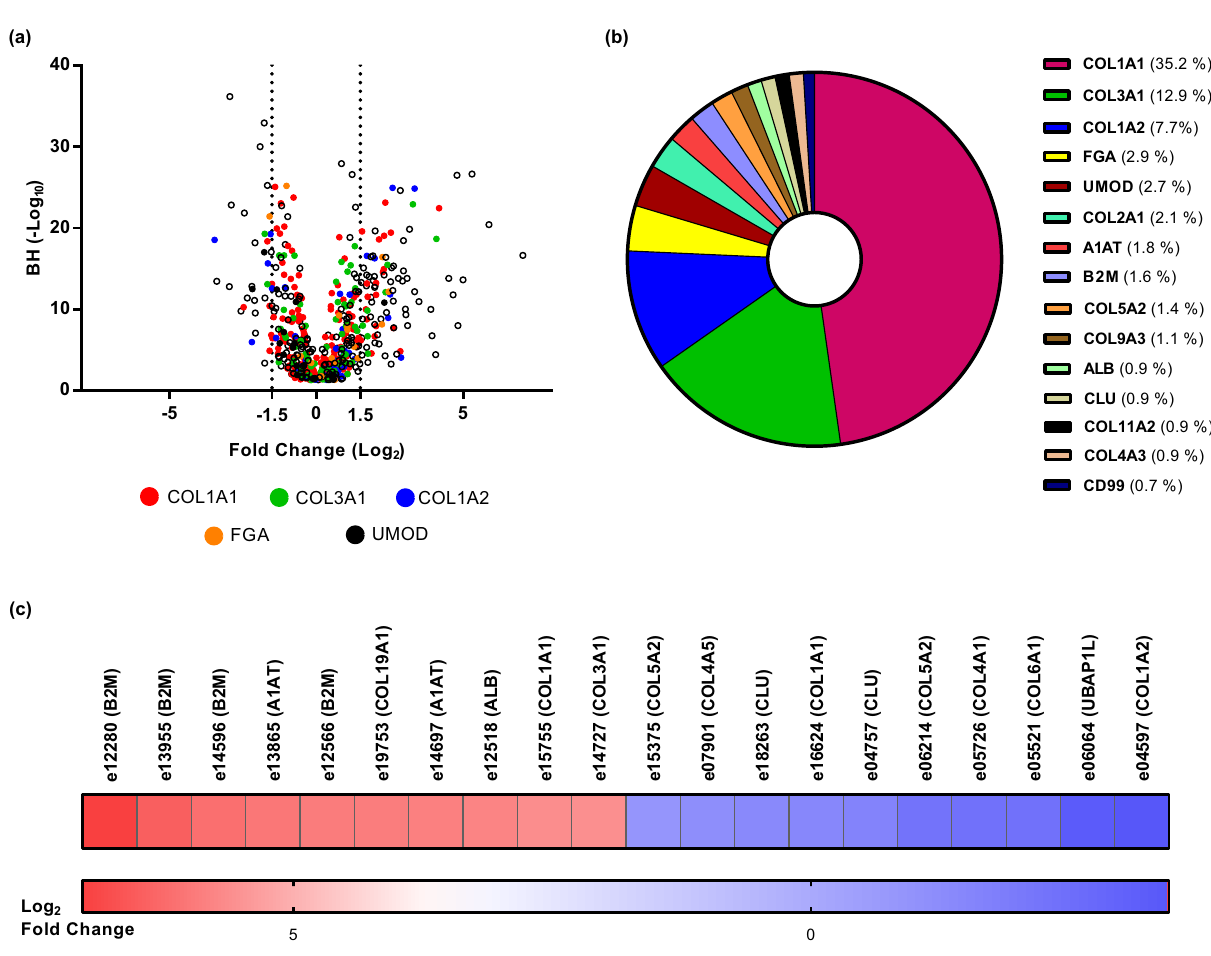
Figure 1. Urinary peptides in CRS. ( a ) Volcano plot showing the fold change (log 2 CRS/Control) plotted against the BH P-value (− log 10 ) of the 559 differentially excreted peptides between CRS and controls. The top five most representative protein precursors including COL1A1, COL3A1, COL1A2, FGA and UMOD are highlighted in different colors. ( b ) Pie chart of the top 15 most frequently observed protein precursors, associated with at least 400 differentially excreted CRS-associated peptides. The percentage of the differentially excreted peptides per protein precursor is presented. 55.9% of CRS-associated peptides originated from fibril-forming collagens and were fragments of COL1A1, COL1A2, and COL3A1. ( c ) Heatmap of the log 2 transformed fold change of the top 10 most increased and decreased peptides in the CRS cohort. In each case, the peptide codes are provided in Supplementary Table